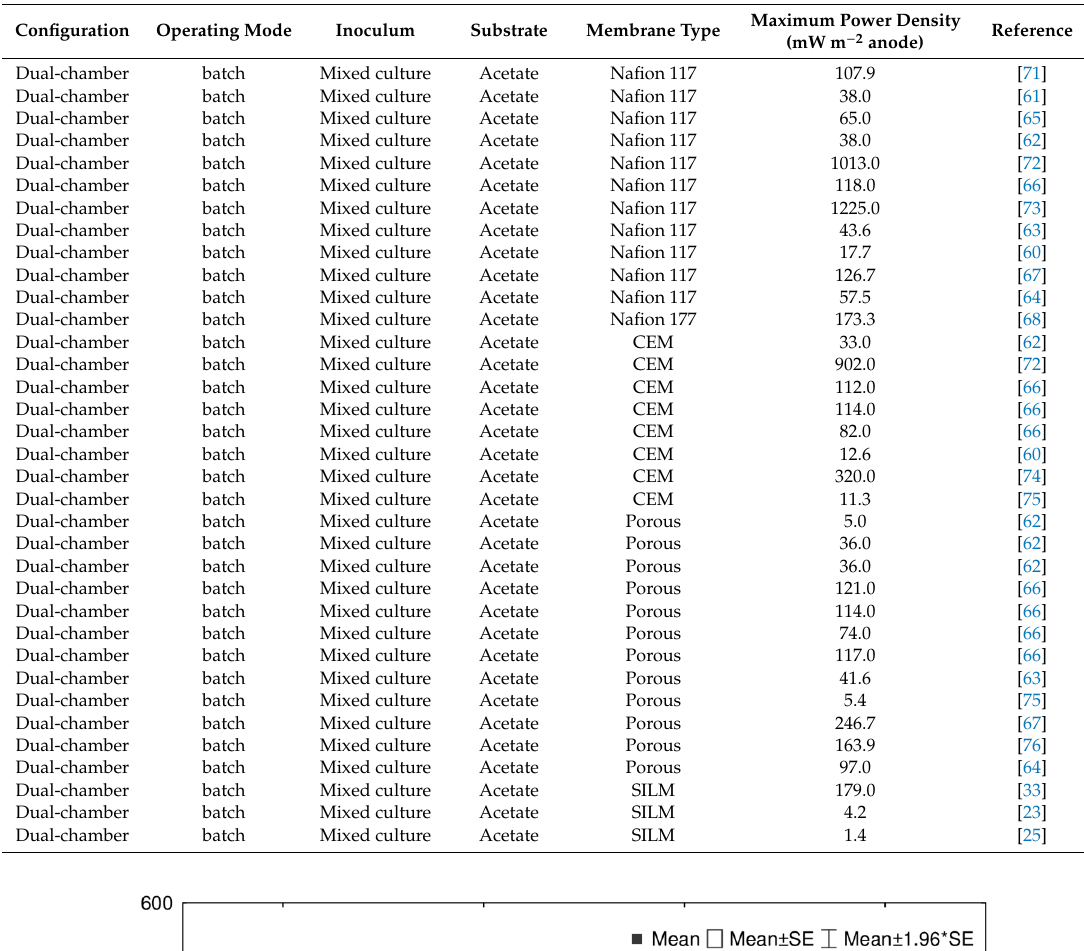
Table 2. Comparative table for MFCs operated with various types of membranes.